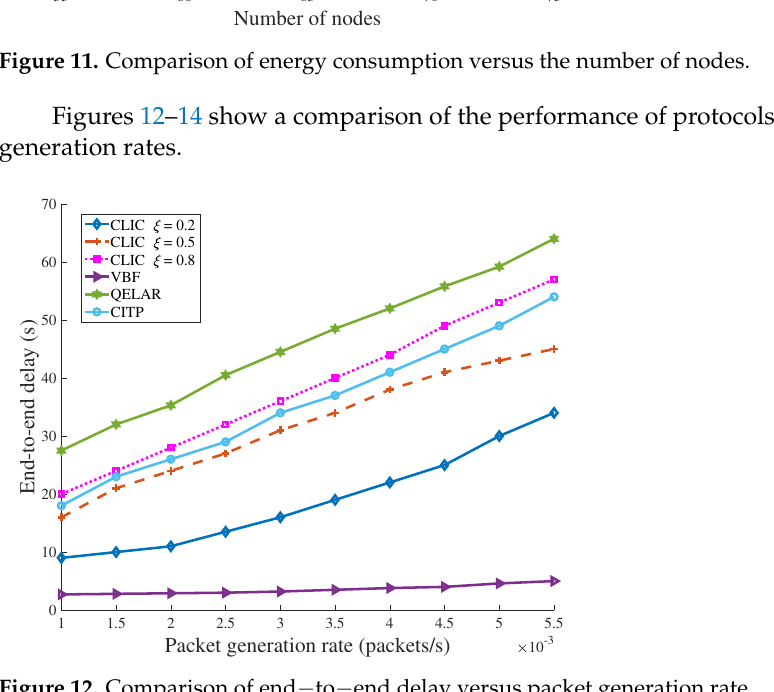
Figure 12. Comparison of end − to − end delay versus packet generation